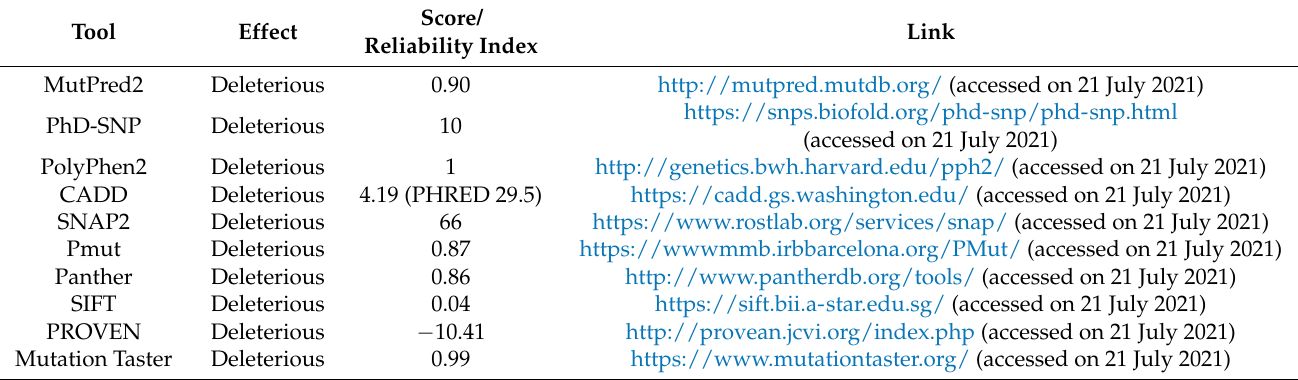
Table 2. Functional prediction of the missense mutation in DYSF gene (c.5033G>A, p.Cys1678Tyr).